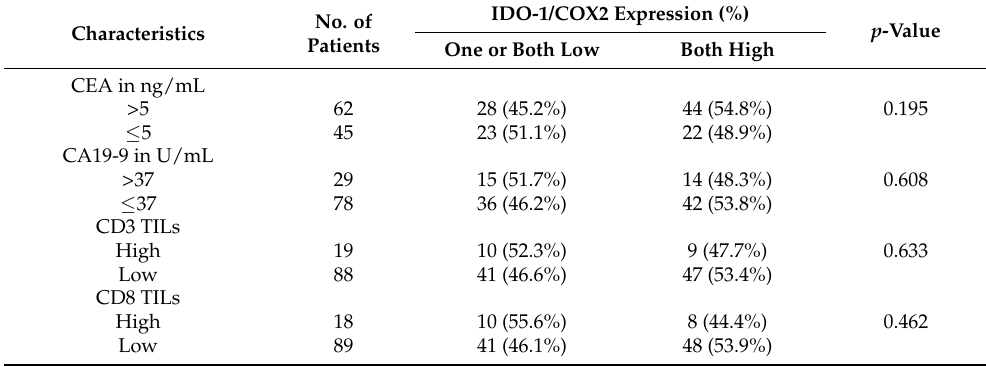
Table 1. Cont. Characteristics